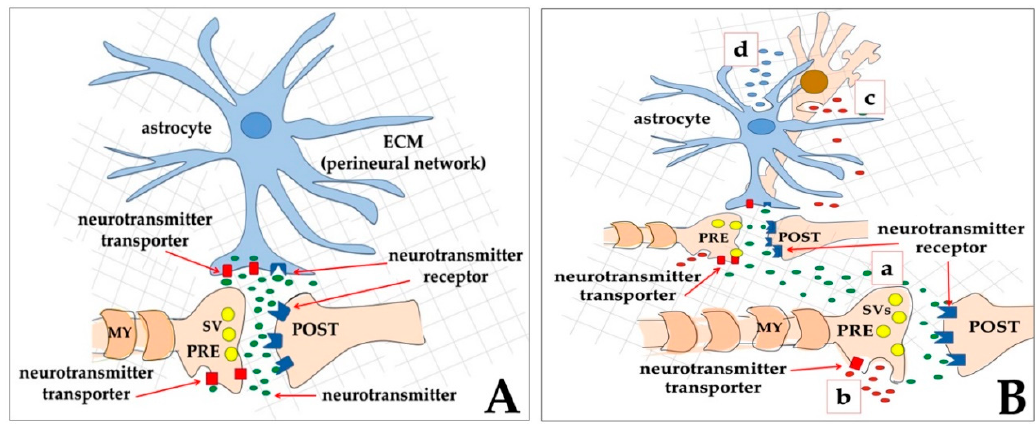
Figure 2. Schematic drawing of two types of neurotransmission, according to the initial proposal of the model [109,110]. ( A ) In the wiring transmission (WT), the presynaptic neuron (PRE) releases neurotransmitter molecules (small green ovals) that bind to their receptors (dark blue) on the post-synaptic element (POST). Excess neurotransmitters are then taken back by the presynaptic neuron through neurotransmitter transporters (red rectangles); In ( B ), a few ways to obtain volume transmission (VT) are represented: (a), the presynaptic neuron (PRE) releases a neurotransmitter (small green ovals) that not only binds to its receptors on the post-synaptic element (POST), but also diffuses at different distances, thus reaching other faraway synapses that will be activated; (b) extrasynaptic release from the axon of signal molecules (small red ovals) into the extracellular matrix, outside the synaptic cleft; (c) extrasynaptic release of signal molecules (small red ovals) from the soma of a neuron; (d) gliotransmitter release from an astrocyte (small blue ovals). In both WT and VT, astrocytes play a central role since they can express on their membranes both neurotransmitter receptors and neurotransmitter transporters, and, in addition, they can release gliotransmitters.